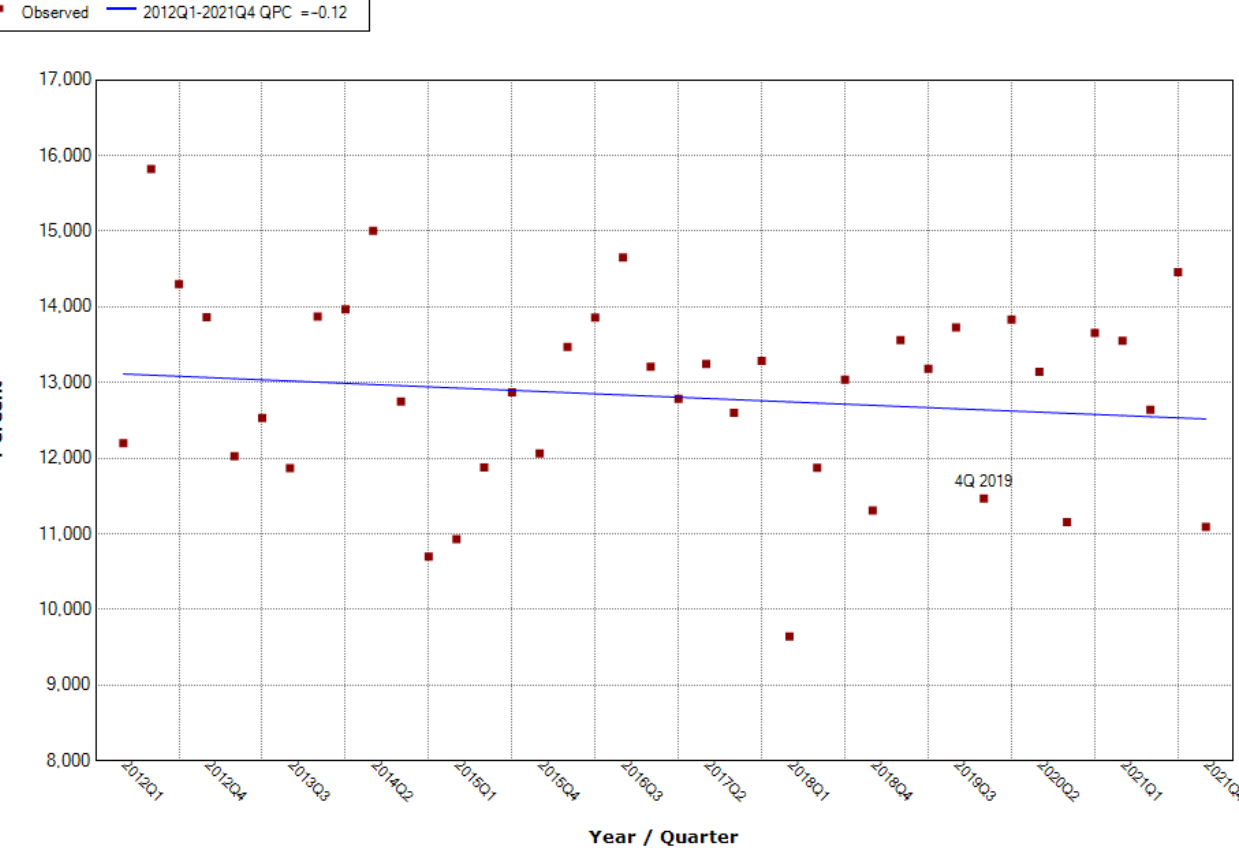
Figure A15. Percentage of products containing vitamin B12 in individual quarters in the period from 2012 to 28 November 2021. Joinpoints mark trend turning points. The date above the observation indicates the moment of publication of the scientific opinion/resolution.